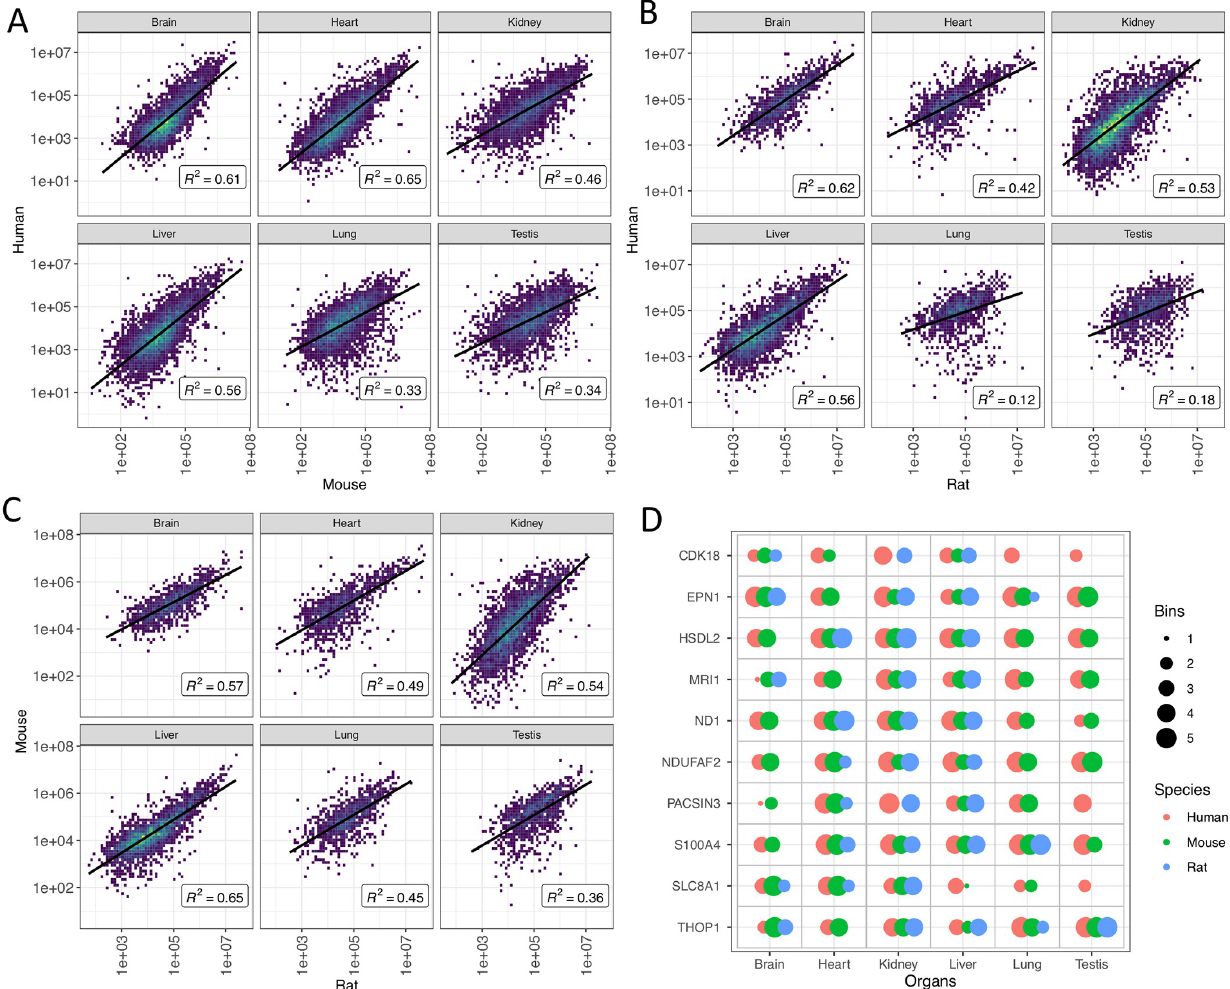
Fig 7. Comparison of protein abundances (in ppb) between one-to-one mapped orthologs of mouse, rat and human in various organs. (A) Pairwise correlation using normalised protein abundances of human and mouse orthologues. (B) Human and rat orthologs. (C) Mouse and rat orthologs. (D) As an example, the comparisons of binned protein expression of ten randomly sampled orthologs are shown. Data corresponding to all cases (as reported in panel D) are available in S7 File and the corresponding illustration of binned values is available in S8 File. Orthologs in (D) are shown using their human gene